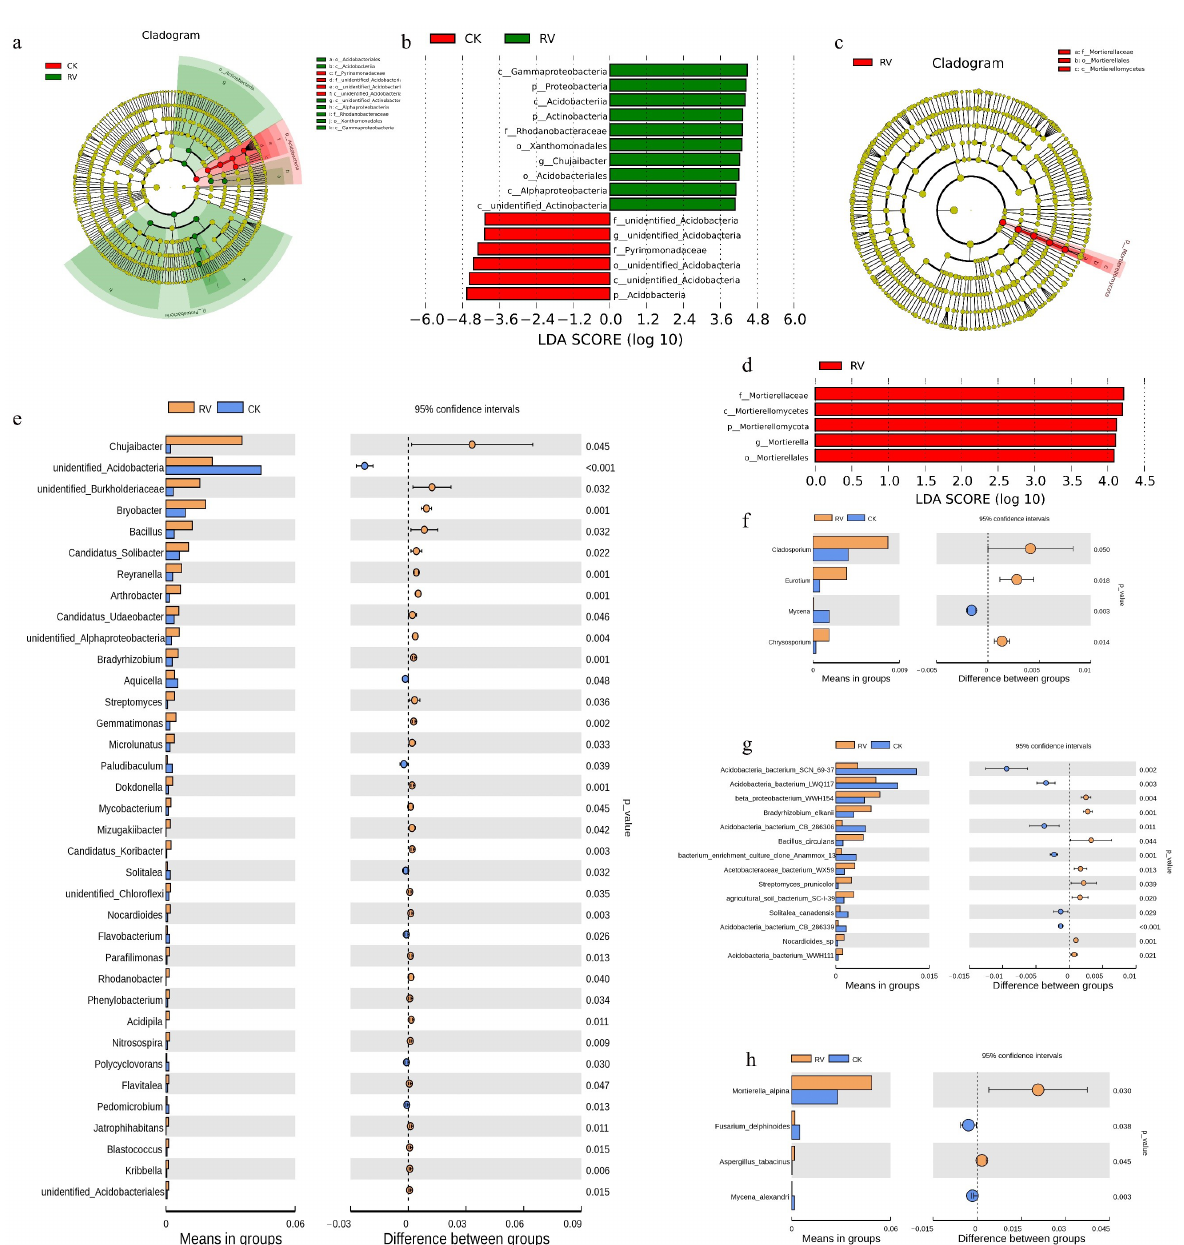
Figure 4. Effects of root-zone aeration on LDA Effect Size and genus-level t -tests: ( a ) Bacterial LEfSe clade map. ( b ) Bacterial LDA value distribution histogram. ( c ) Fungal LEfSe clade map. ( d ) Fungal LDA value distribution histogram. ( e ) Bacterial differential species abundance. ( f ) Fungal differential species abundance. ( g , h ) Significant differences in soil microbial counts at the species